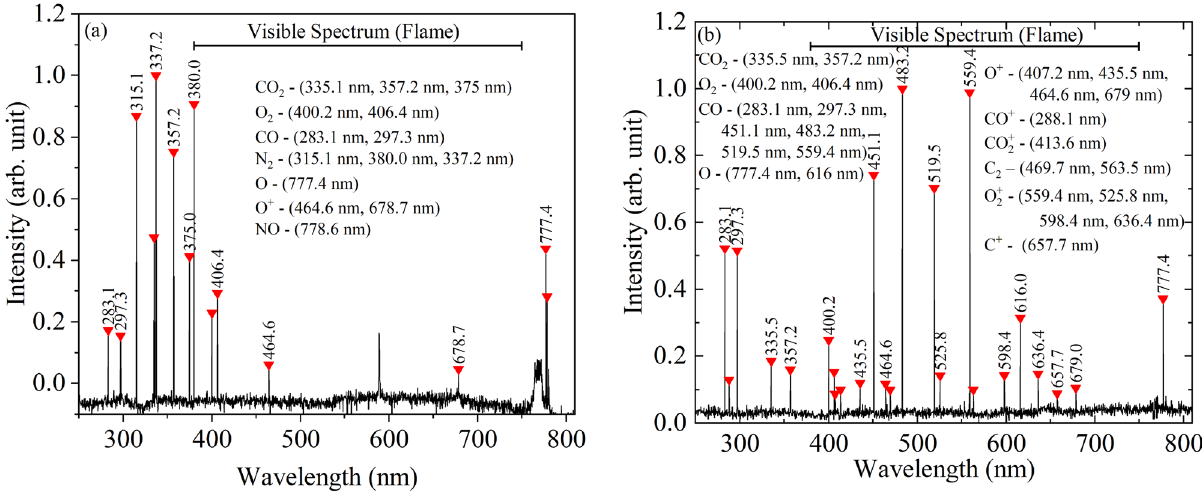
Figure 8. Optical emission spectrum ( a ) No-film mode at 673 K and 20% O 2 ; ( b ) Film mode at 1073 K and 100% O 2